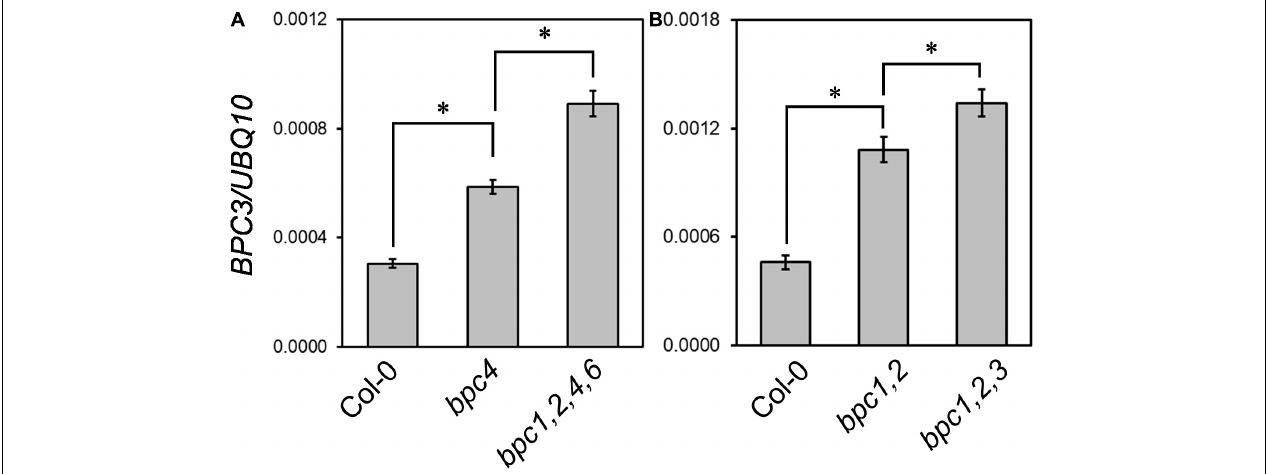
FIGURE 2 | BPC family members antagonize the transcript level of BPC3. The expression levels of BPC3 were determined in 18-day-old plants of Col-0, bpc4 , bpc1,2,4,6 (A) , Col-0, bpc1,2 , and bpc1,2,3 (B) by using qRT-PCR analyses with the amplicon “b” of BPC3 shown in Figure 3A . Data are mean ± S.E. ( n = 3 technical replicates, one independent biological replicate was presented in Supplementary Figure 1 ). Asterisks indicate BPC3 transcript levels of different genetic backgrounds were significantly different (Student’s t- test; ∗ P < 0.01).